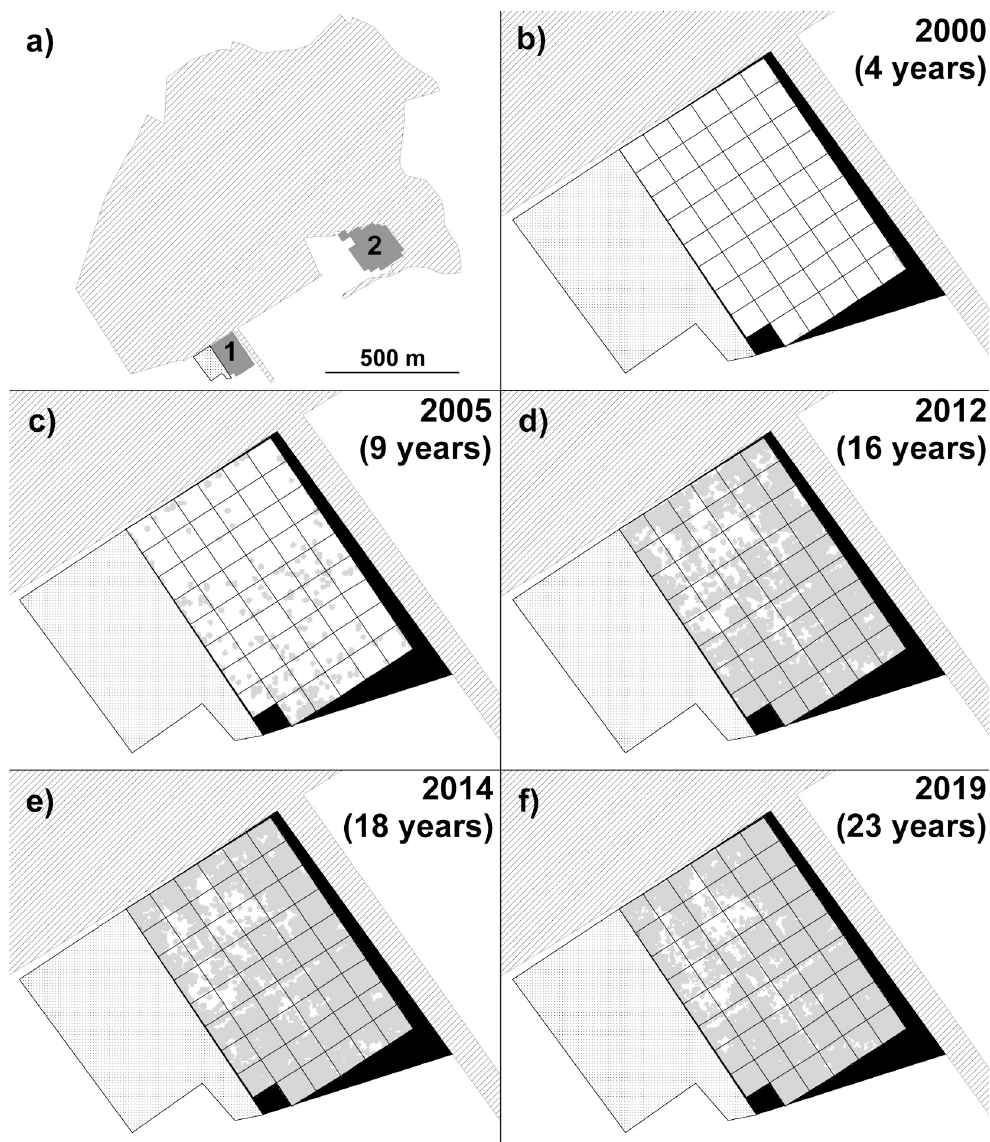
Fig 1. Study sites and New Wilderness development. Wilderness study sites in relation to Monks Wood ancient woodland and associated mature hedgerow (hatched area) and block of unstudied scrub (stippled area): a) location of the New Wilderness study area (dark grey block marked ‘1’) and Old Wilderness (dark grey block marked ‘2’); Panels b) to f): Time series of remote sensing (lidar 2000–2014, structure-from-motion photogrammetry 2019) data for the New Wilderness for data collected in a given year (and number of years since Wilderness abandonment in 1996). Pale grey areas denote extent of woody vegetation of � 0.5 m but below 8 m tall. White areas are grass/herb vegetation below 0.5 m tall. Black areas denote unstudied parts of the New Wilderness area. Grid cells are 20 x 20